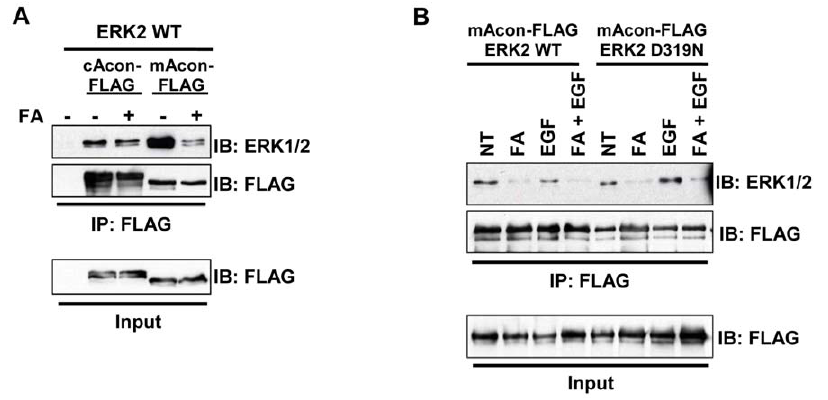
Figure 7. Identification of an ERK-aconitase protein complex that is disrupted by aconitase inhibition. ( A ) Assessment of ERK-aconitase interactions by coexpression followed by coimmunoprecipitation. ERK2 and FLAG-tagged cytosolic aconitase (cAcon-FLAG) or mitochondrial aconitase (mAcon-FLAG) were coexpressed in HEK293T cells 6 500 m M FA. Immunoprecipitation (IP) with FLAG beads was followed by immunoblotting (IB) for total ERK and for the FLAG epitope. ( B ) Role of ERK D-domain interacting motif in ERK2 binding to mitochondrial aconitase. mAcon-FLAG was coexpressed with ERK2 WT or D319N in HEK293T cells 6 500 m M FA, 6 100 ng/ml EGF, followed by IP and IB as in panel A .